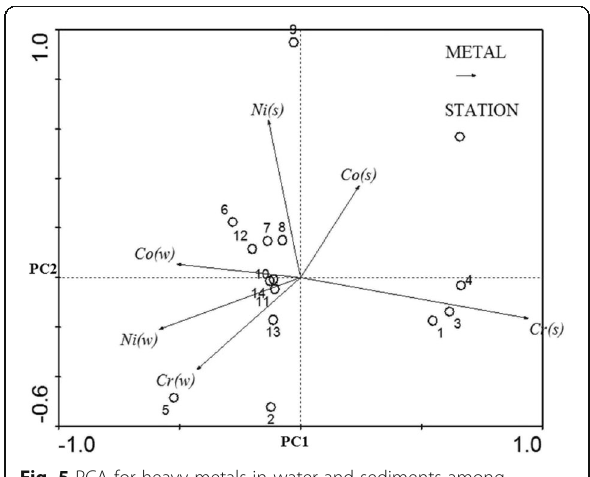
Fig. 5 PCA for heavy metals in water and sediments among different